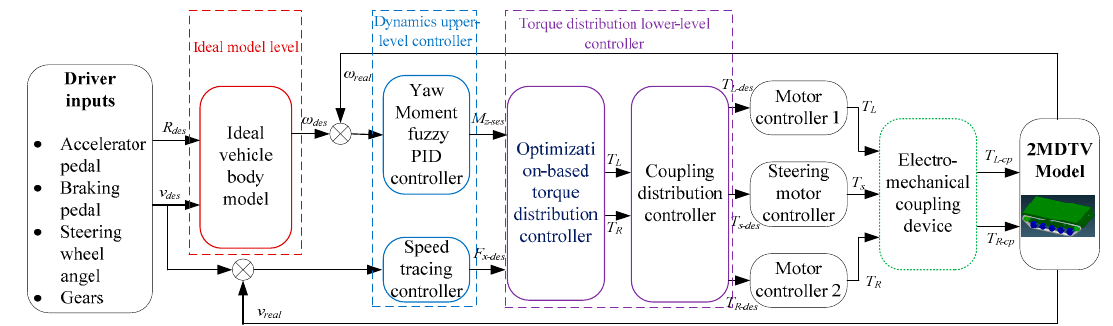
Figure 5. Control strategy schematic based on torque.